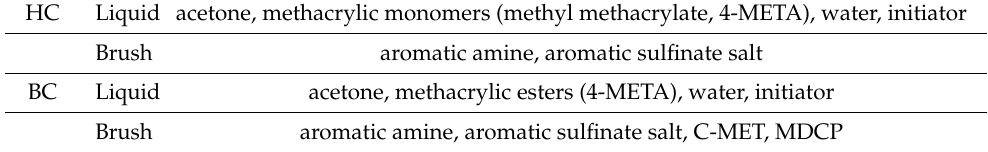
Table 1. Composition of Hybrid Coat II (HC) and Bio Coat Ca